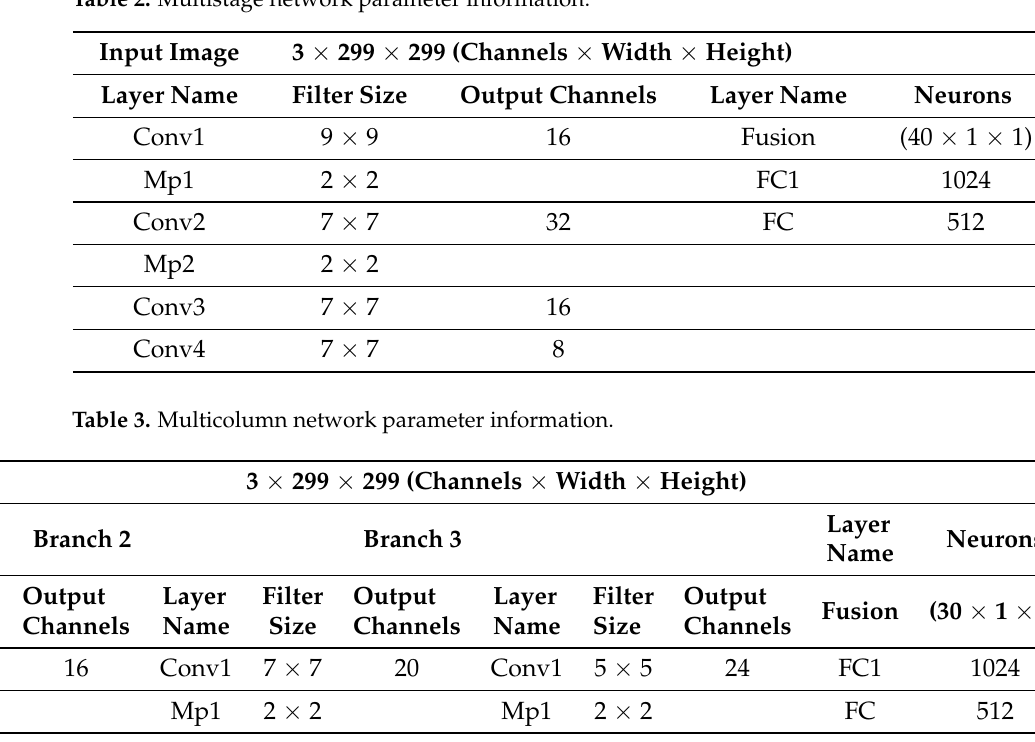
Figure 3. Modified MSCNN architecture. Table 2. Multistage network parameter information.